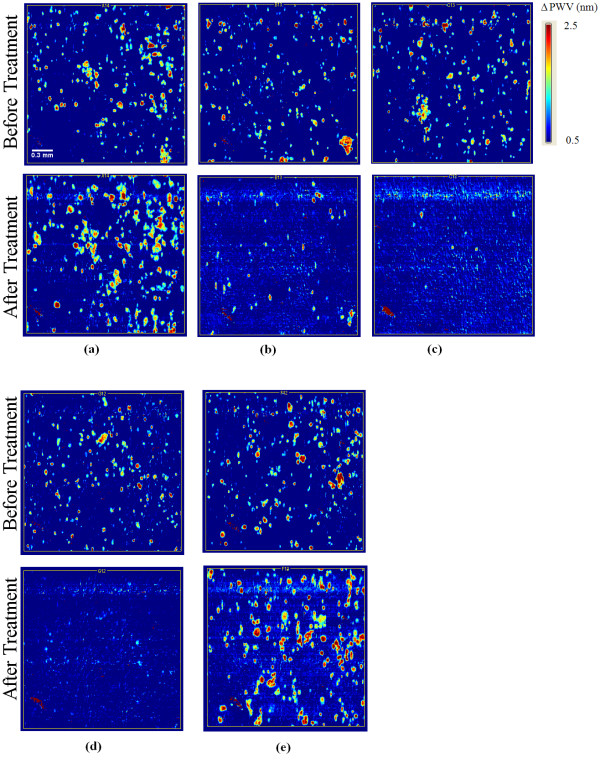
PWV shift images in false color with shift scale bars indicating the magnitude of wavelength shifts in nanometers. Pixels with higher PWV displayed in brighter colors, indicate locations where Panc-1 cell attachment has occurred. The five image sets represent the following (a) untreated control, (b) positive control (DOX), (c) positive control (Curcumin), (d) extract that induced 100% cell death (P. punctata, No. 34), (e) extract that enhanced proliferation (A. glabra, No. 11). In each image set, the top image was taken before exposure and the bottom image was taken after the 24 hour exposure period with a plant extract or positive control at 100 μg/mL. Scale bar (white) = 300 μm.